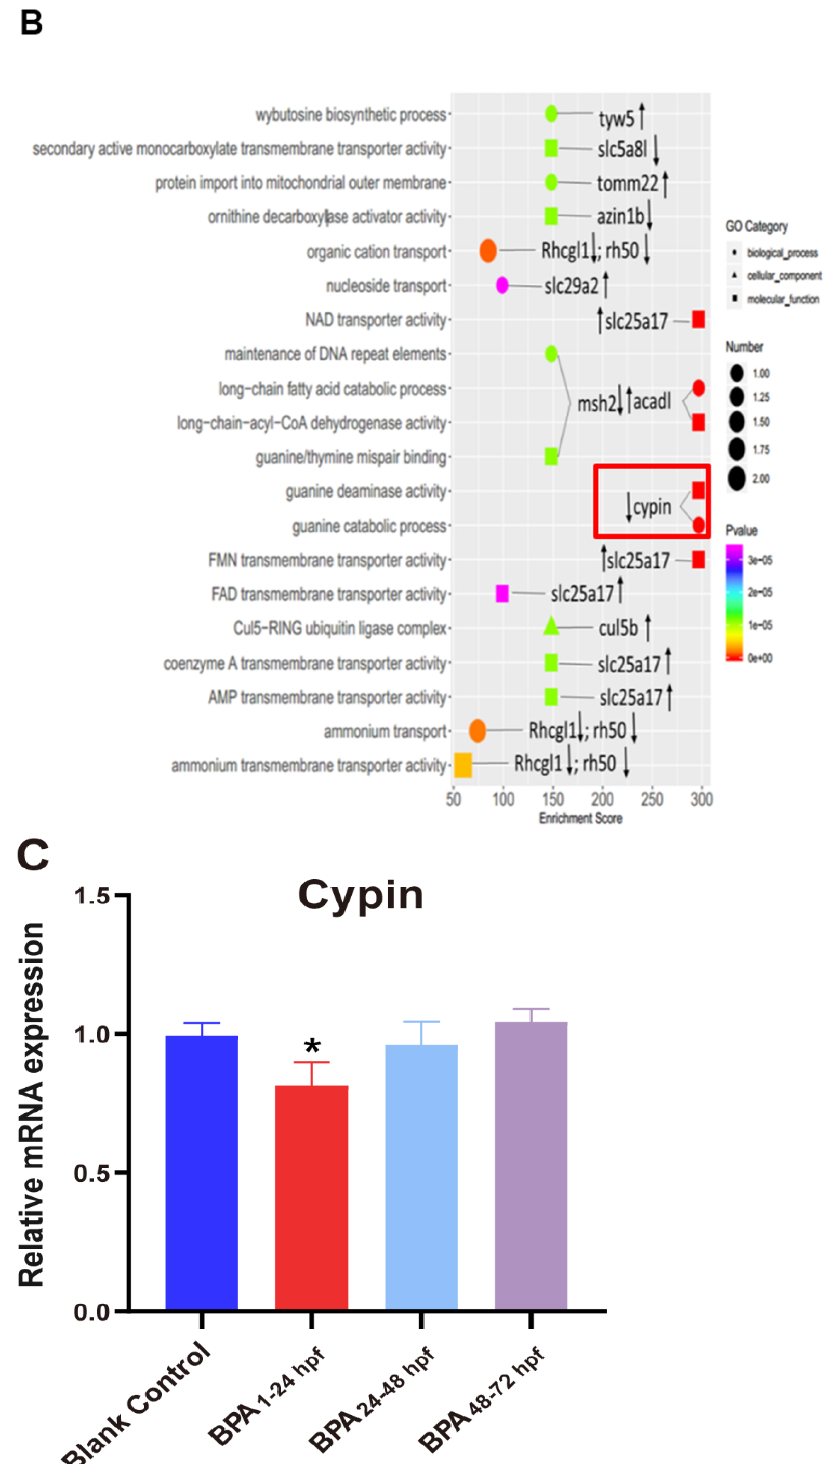
Figure 5. Transcriptome analysis of zebrafish from the cleavage period to the segmentation period (1–24 hpf), pharyngula period (24–48 hpf) and hatching period (48–72 hpf) induced by BPA. ( A ) Cluster analysis heatmap. Red indicates increased gene expression, and blue indicates decreased gene expression. ( B ) GO function enrichment analysis bubble diagram for differentially expressed genes. ( C ) The expression of cypin. Data are the mean ± SD (30 embryos per sample, and repeat three times), *, significant from blank control, p < 0.05.